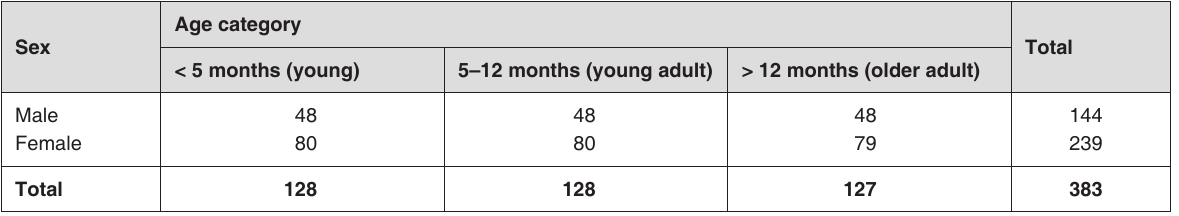
The age of the sampled pigs was determined on the basis of the pig keeper’s declarations combined with teeth examination and measurement of body size